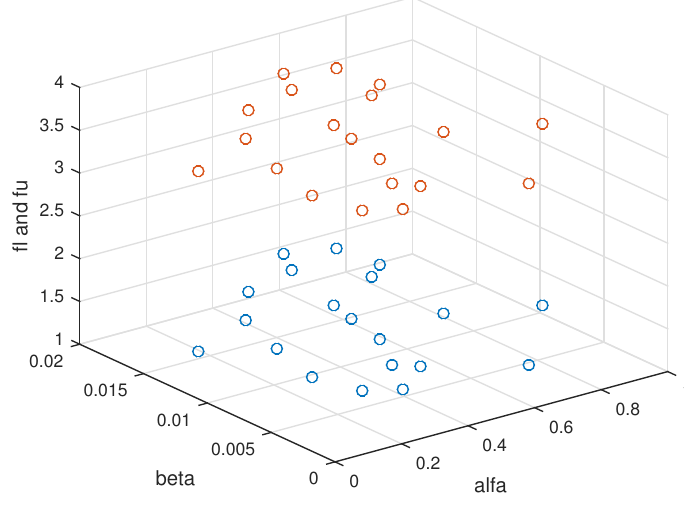
Figure 1. Efficient space for Example 3 with SOC constraint using n = 20.